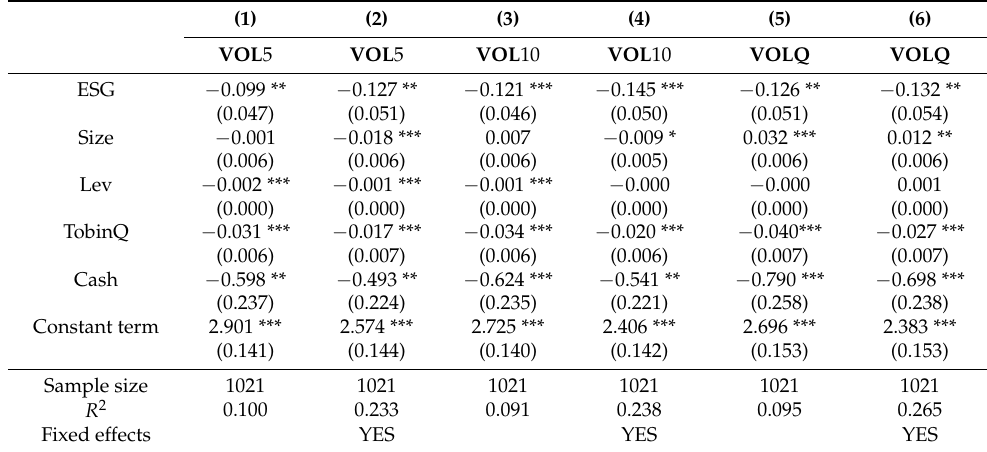
Table 3. Regression results of ESG and corporate volatility during